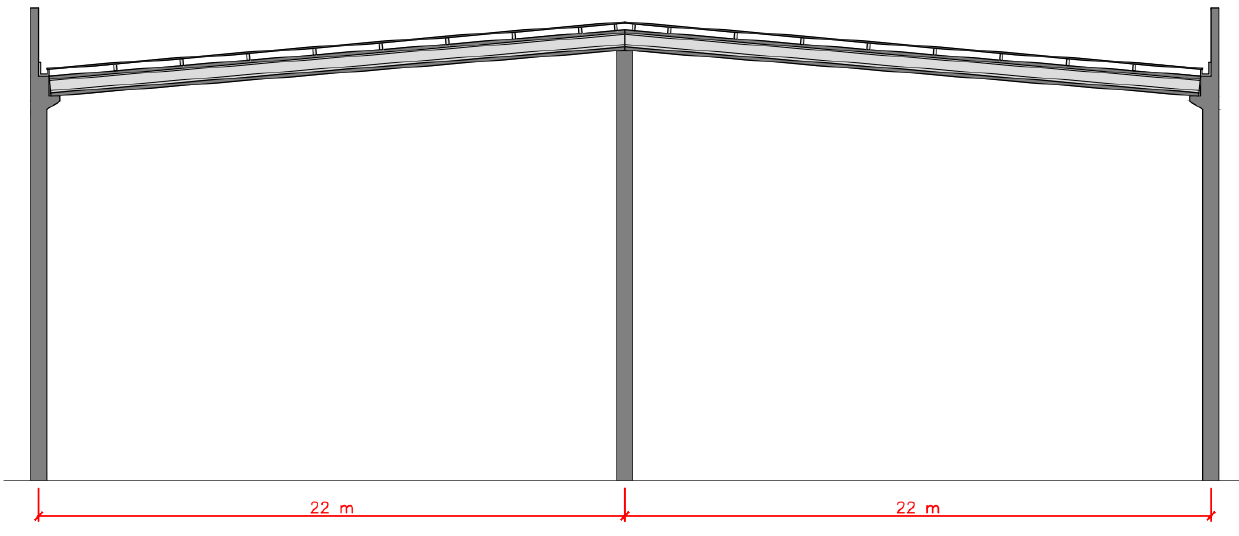
Figure 2. The internal frame of the industrial shed.